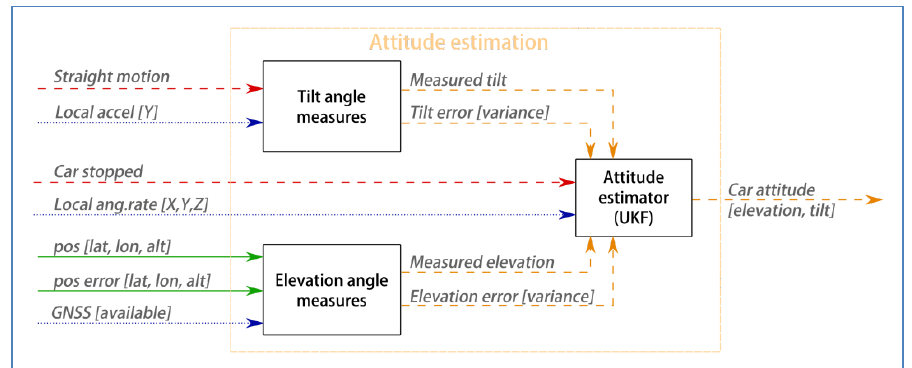
Figure 11. Attitude estimation